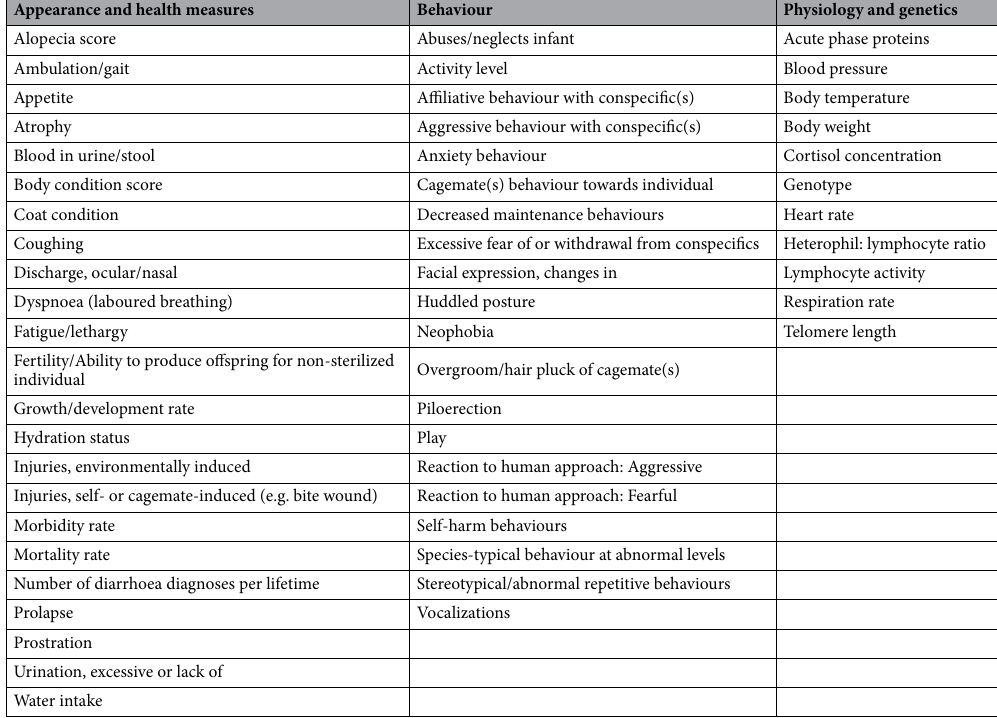
Table 8. Initial list of potential animal-based